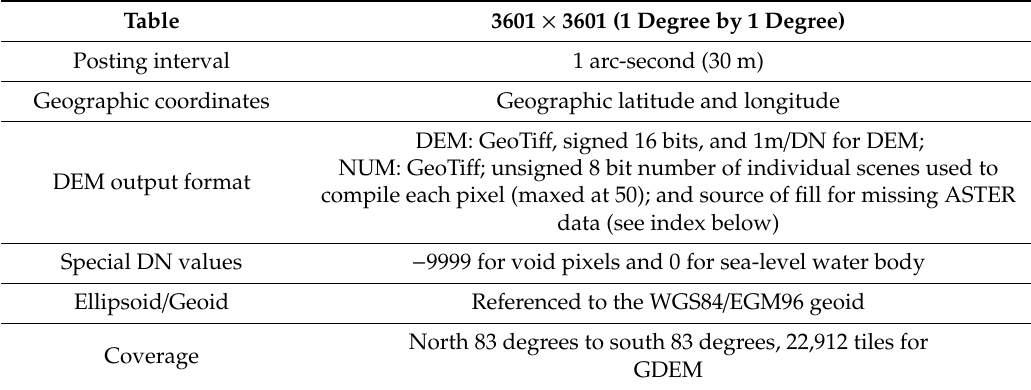
Table 2. GDEM characteristics.